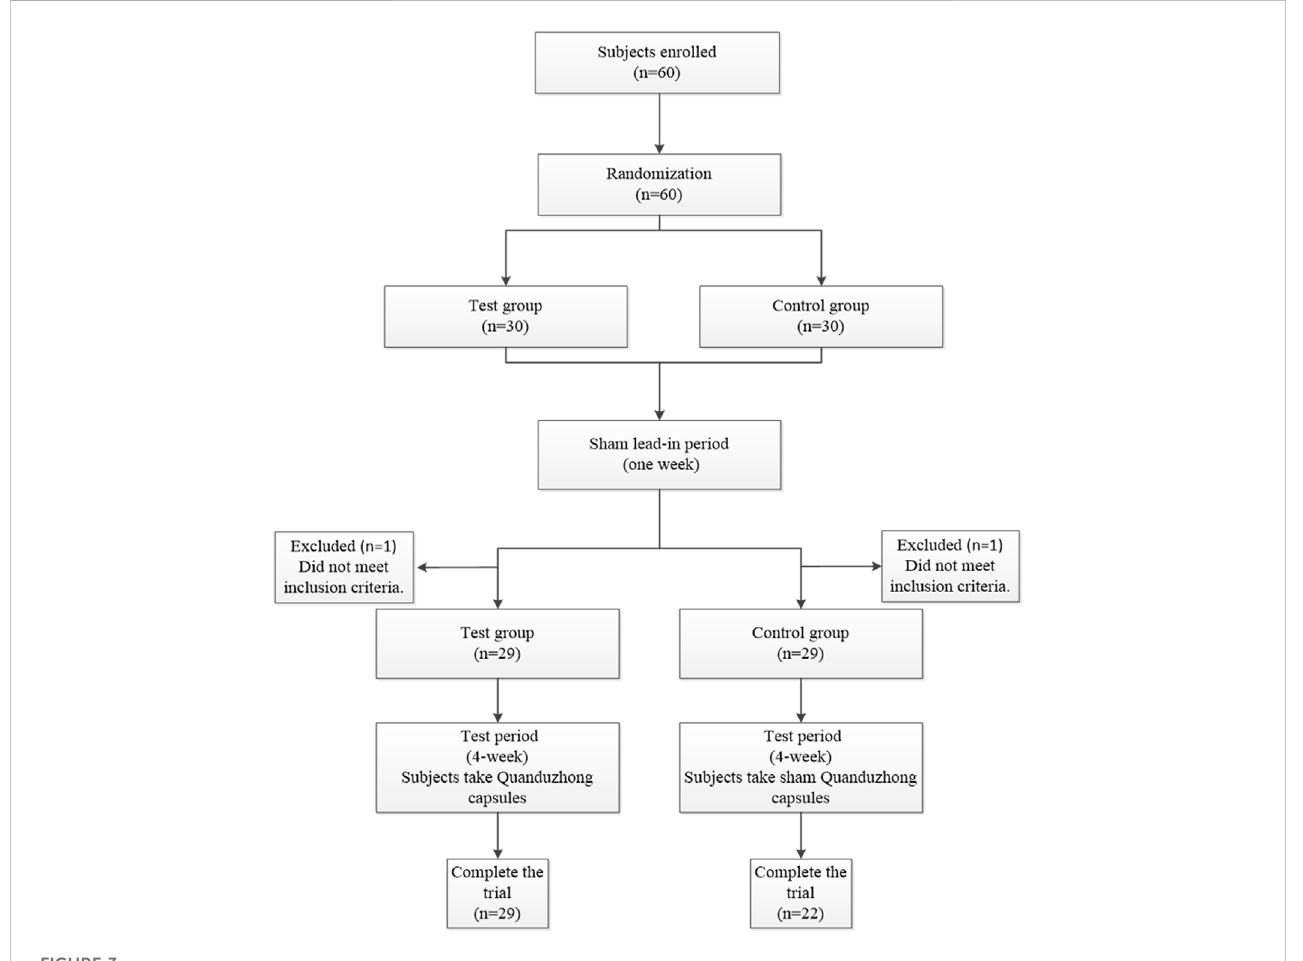
FIGURE 3 Flow chart of the